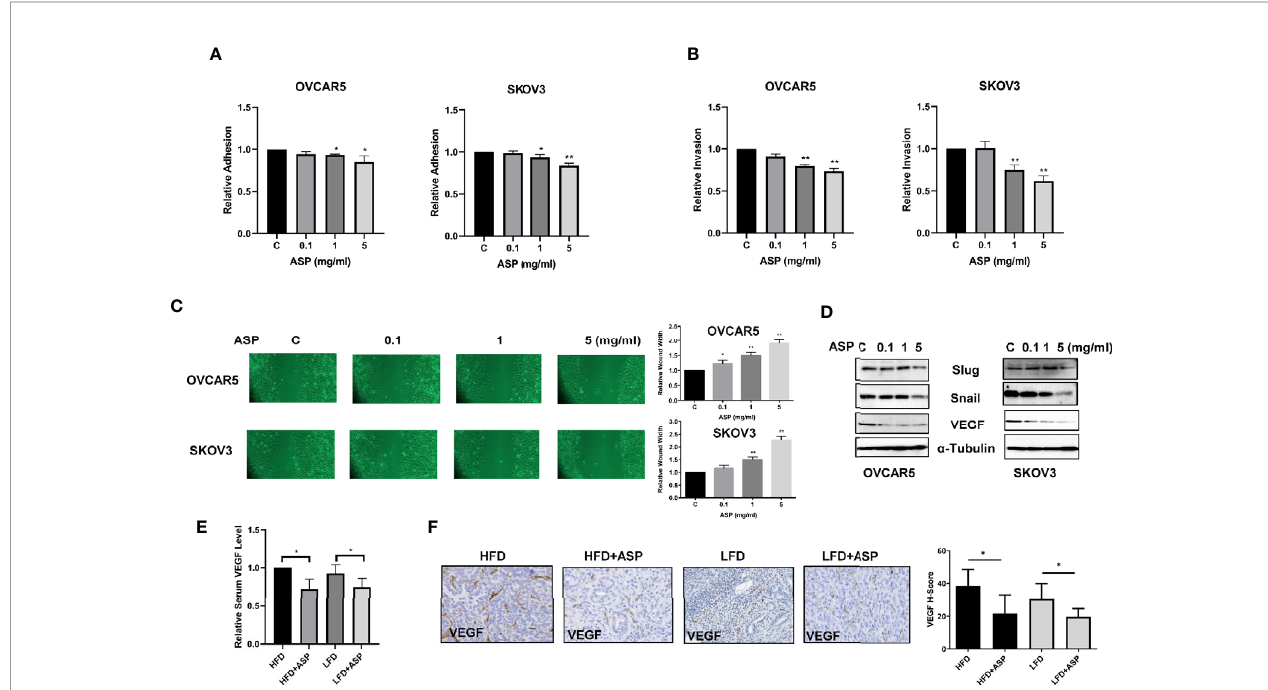
FIGURE 6 | ASP inhibited adhesion and invasion. The OVCAR5 and SKOV3 were treated with ASP at a range of doses from 0.1 − 5 mg/ml. laminin-1 assay showed that treatment OVCAR5 and SKOV3 cells with ASP for 2 hours signi fi cantly reduced cell adhesion (A) .Invasion was determined by transwell assay after 4 hours of treatment with ASP. ASP signi fi cantly reduced cell invasion in a dose-dependent manner in both cells (B) . Migration was assessed by wound healing assay after treatment with ASP for 48 hours. The results showed that ASP reduced OC cell migration (C) . Western blotting found that ASP reduced the expression of VEGF, Snail and Slug in both cell lines (D) . The obese and lean KpB mice were treated with 200 mg/kg ASP for 4 weeks. ASP decreased serum VEGF products in both obese and lean mice (E) . IHC results showed that ASP reduced VEGF expression in both obese and lean mice (F) . *p < 0.05, **p <